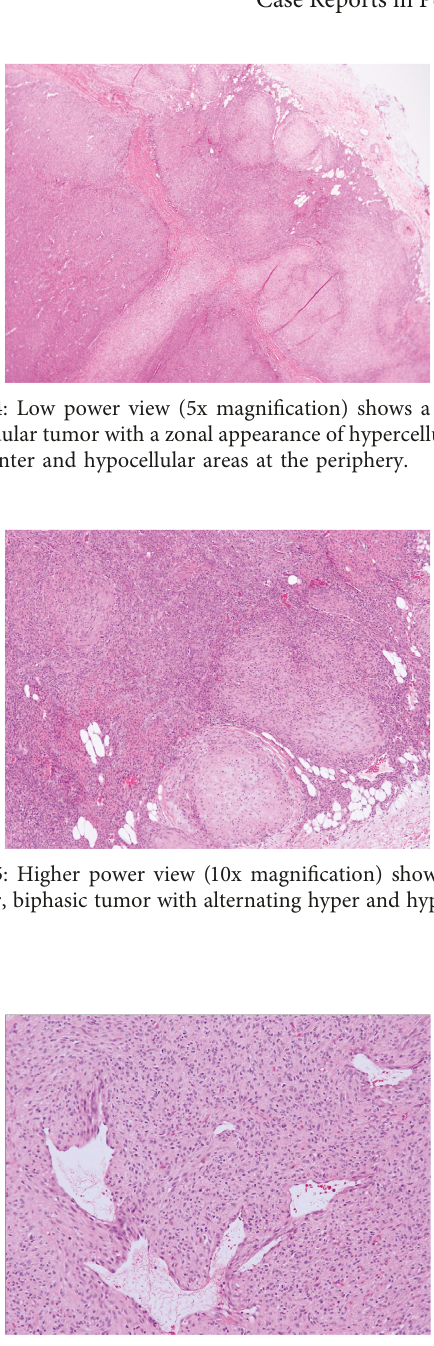
Figure 6: High-power view (20x magnification) shows numerous hemangiopericytoid slit-like vessels in the center of the